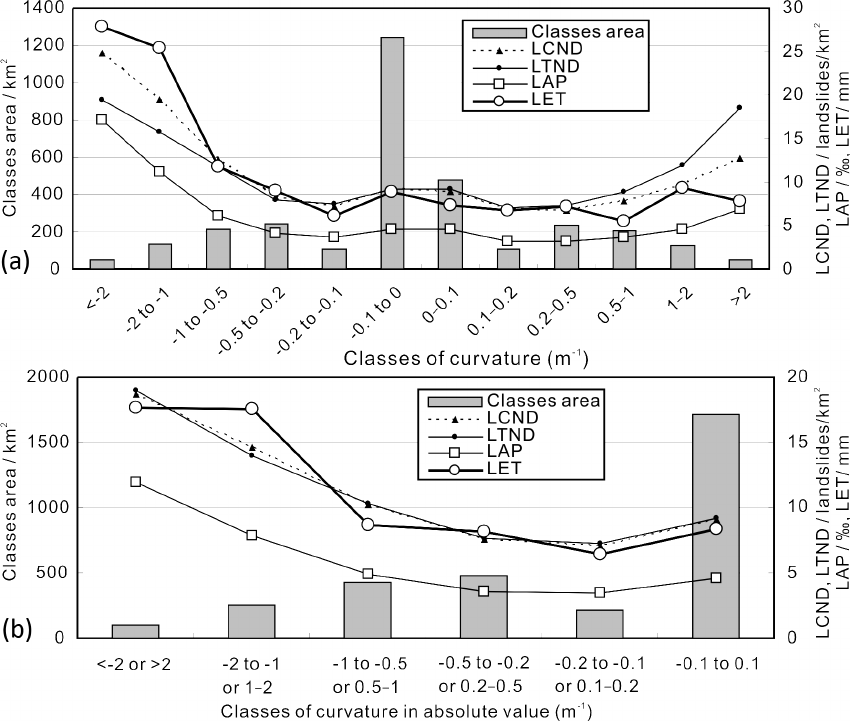
Figure 20. Relationships between co-seismic landslides and slope curvature. (a) Classes divided considering the sign of slope curvature, and (b) classes divided without considering the sign of slope